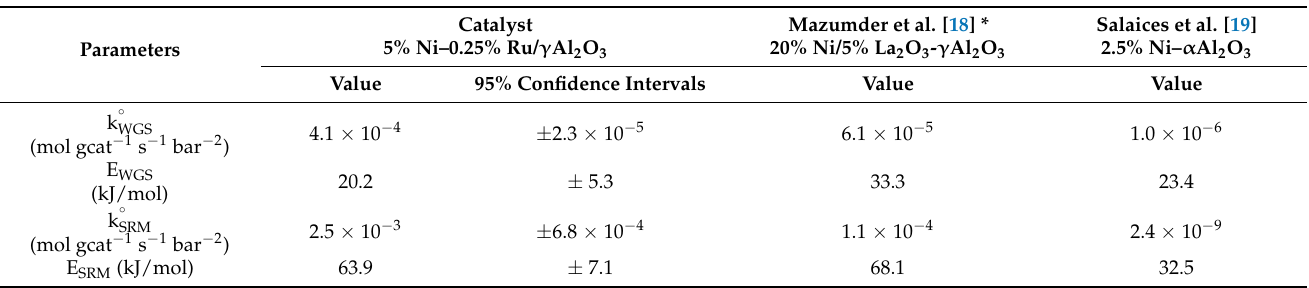
Table 8. Estimated kinetic parameters in the steam gasification of 2-methoxy-4-methylphenol with the catalyst 5% Ni–0.25% Ru/ γ Al 2 O 3